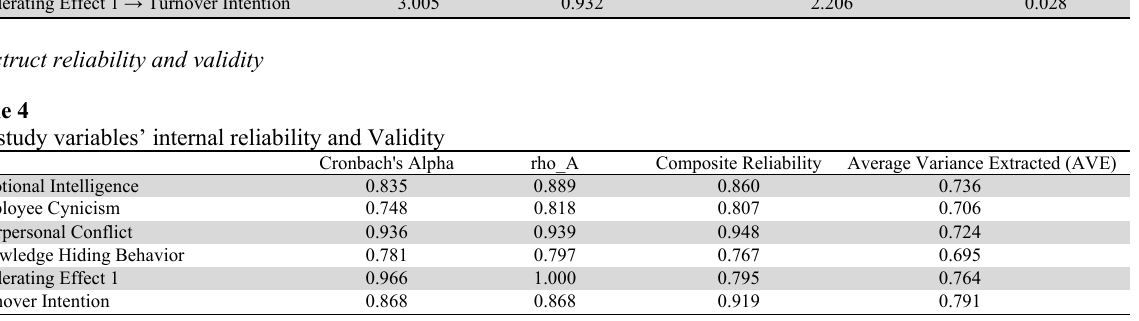
The Moderating Effect between Emotional Intelligence and Turnover Intention Emotional intelligence → Turnover Intention